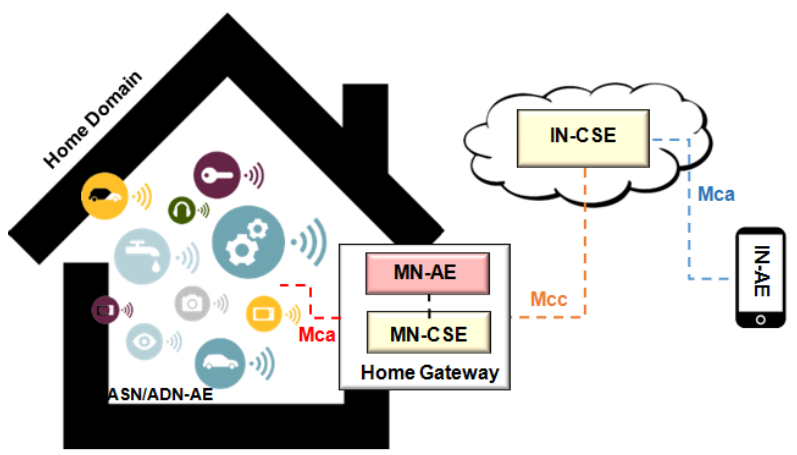
Figure 25. Illustration of the ONEM2M